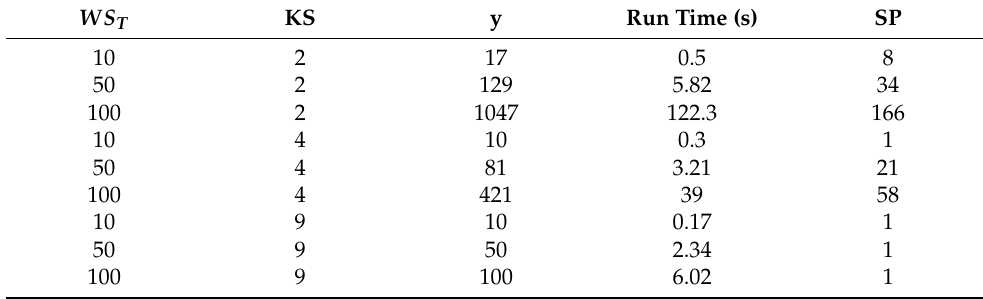
Table 2. Runtime results using